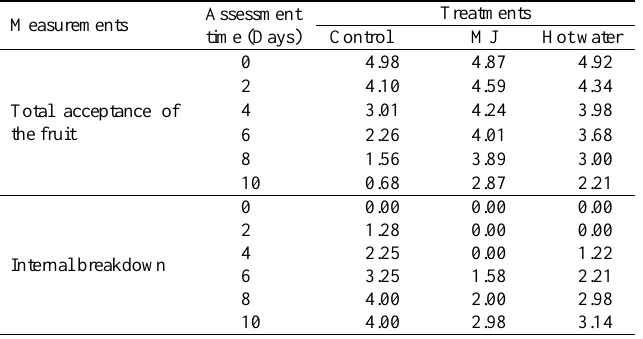
Table 1 . Effects of different post-harvest treatments on total acceptance and internal breakdown of apricot at shelf life (MJ: methyl jasmonic acid). Measurements